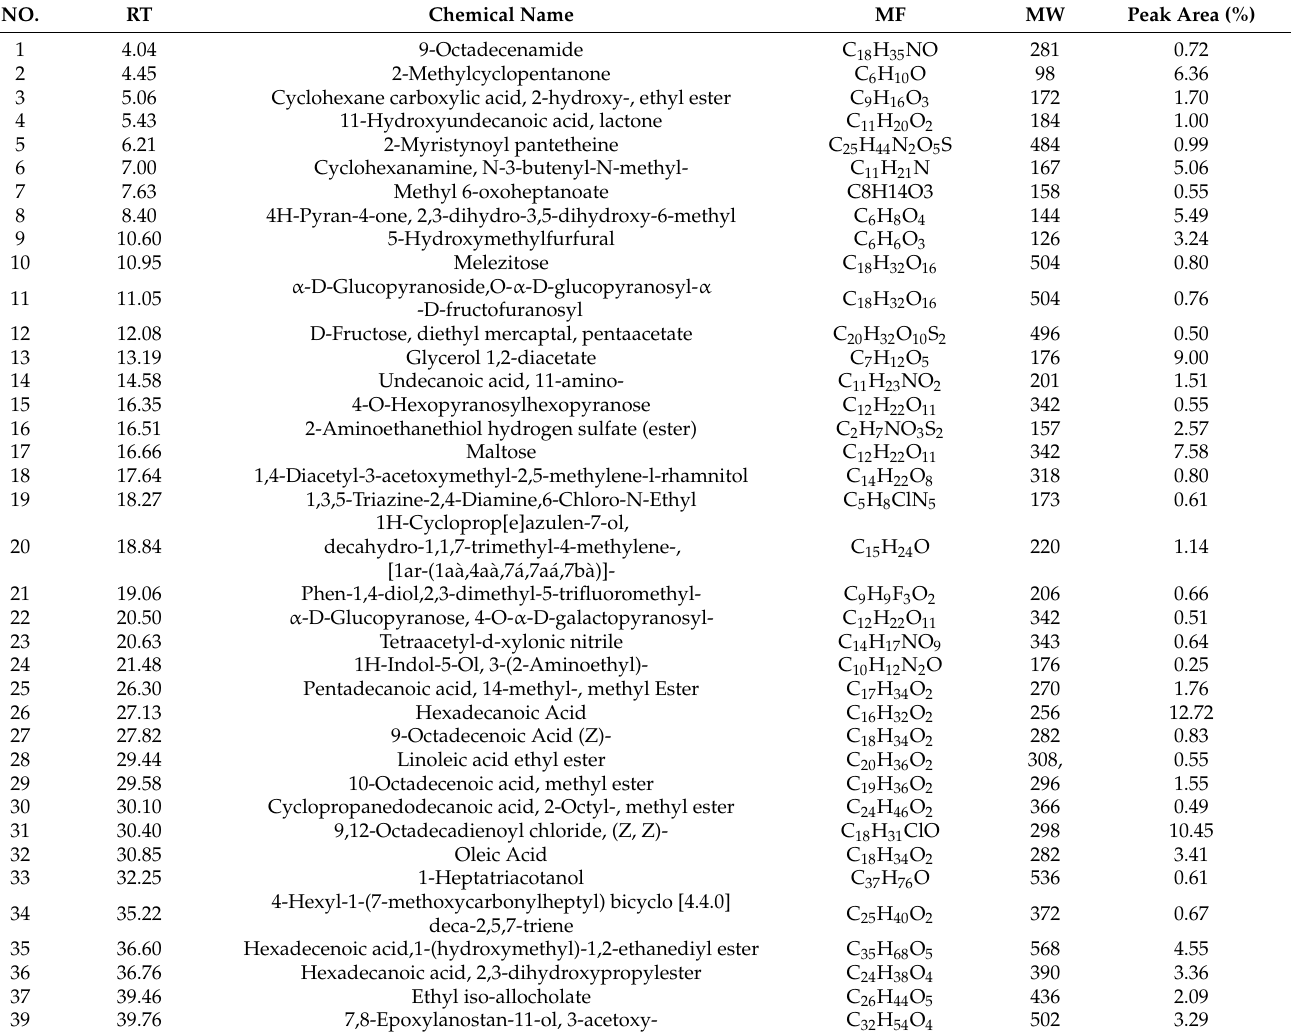
Table 3. GC–MS analyses of the